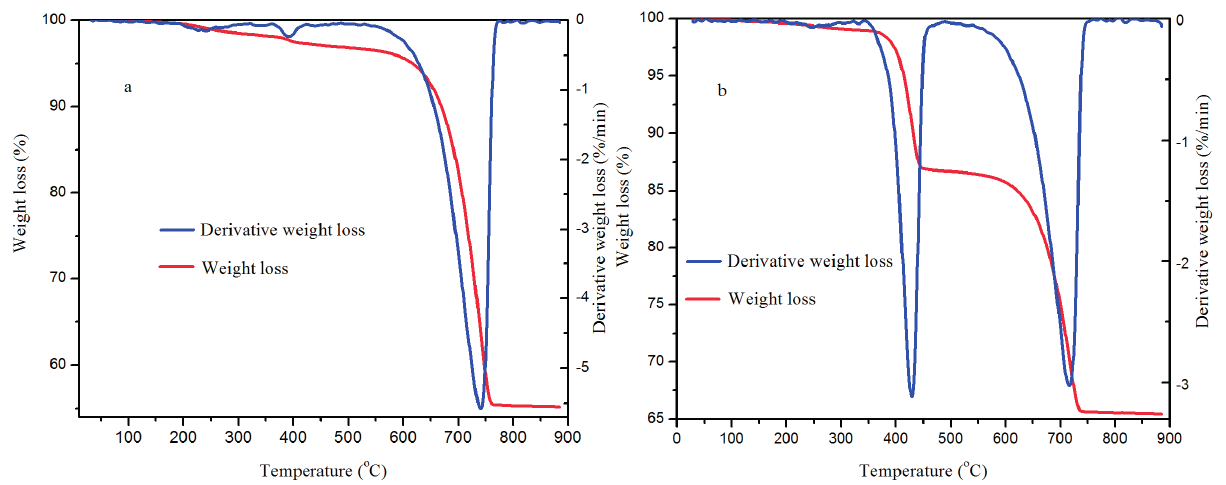
produced: ( a ) 5.0 MPa and ( b ) 0.1 MPa 3